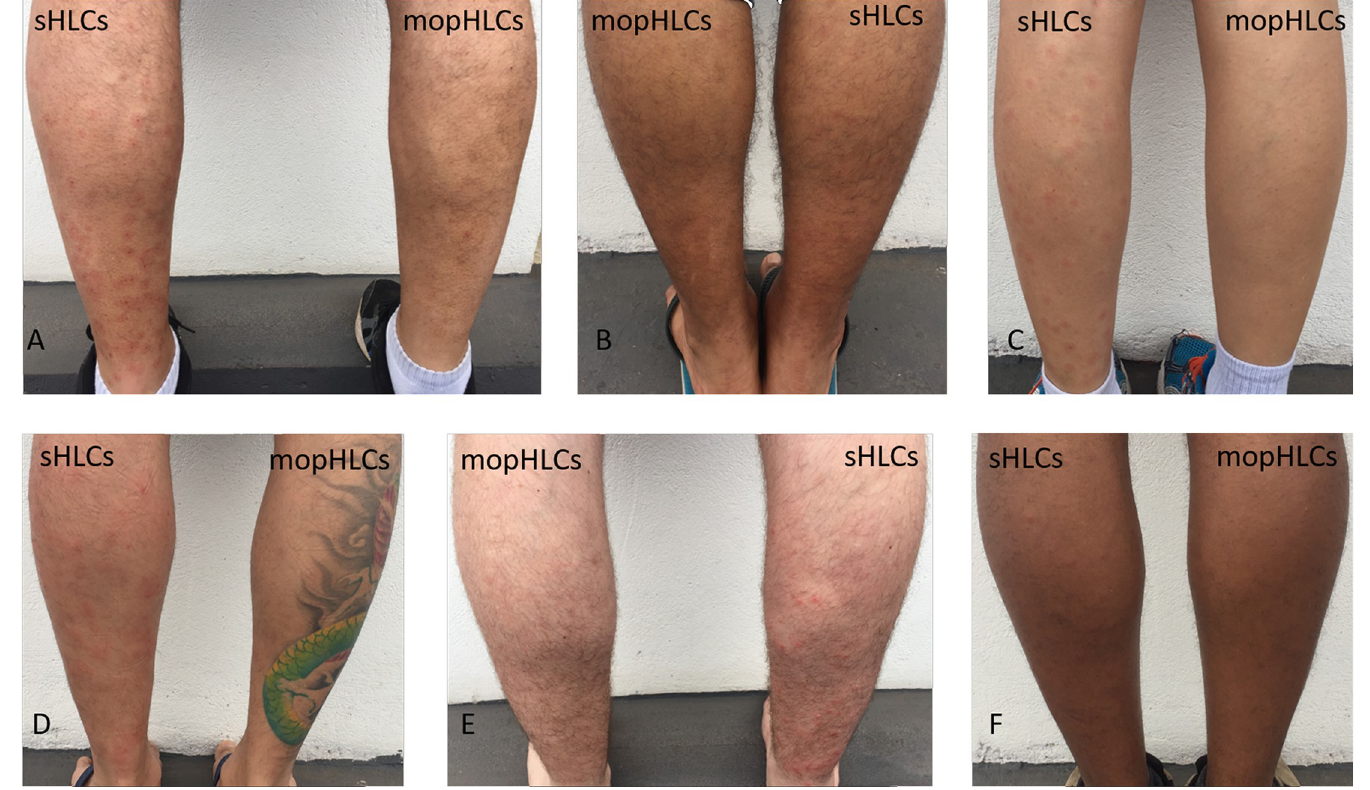
Fig 2. Shows photographs of the legs of our six vector collectors after our final day of simuliid collection (the 28th of October 2017), with the trapping method used indicated. Simuliid bite mark count data from the day these photographs were taken can be seen in Table 1. The legs of our vector collectors are show in the following sequence: FACP (panel A); JMPS (panel B); CAC (panel C); TRRS (panel D); JLC (panel E) and YVSS (panel